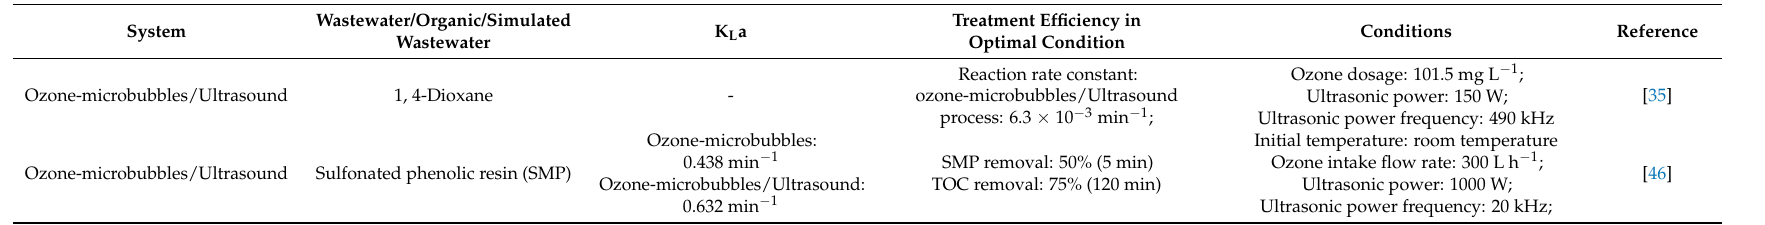
Table 3. Overview on wastewater treatment through ultrasonic catalytic microbubbles ozonation